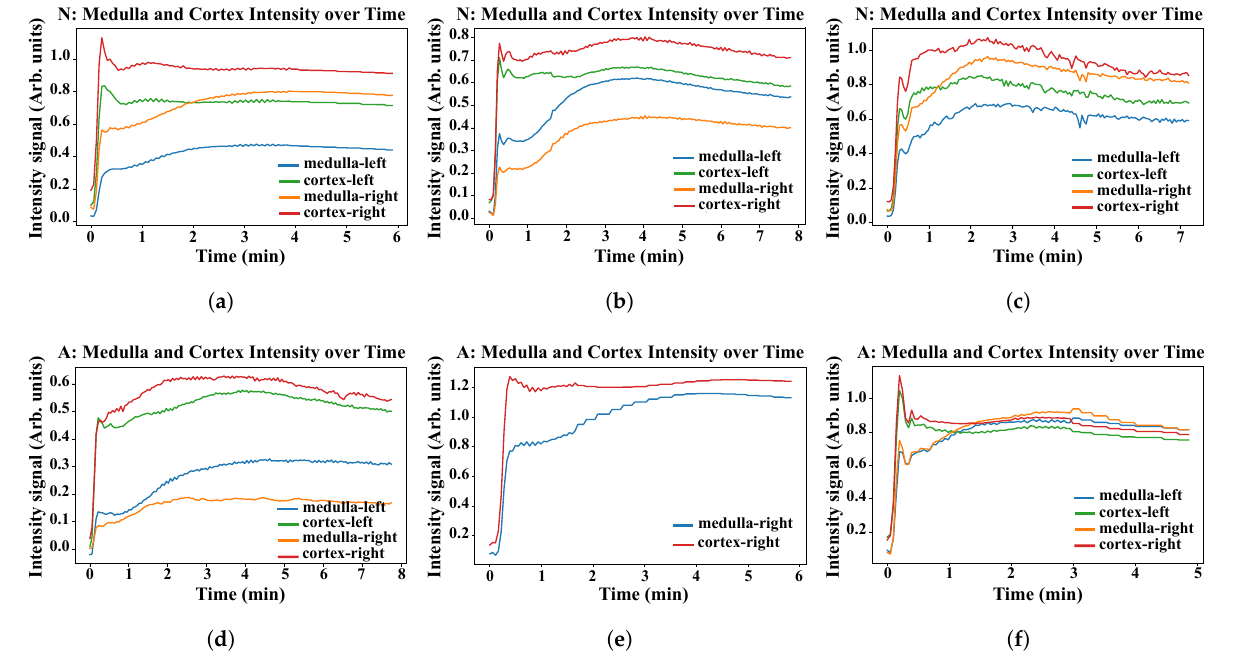
Figure 7. Graphs ( a – f ) represent clinically “normal” and “abnormal” cases (scans or 4D volumes), respectively. The relative contrast intensity enhancement of the (automatically segmented) medulla and cortex in both the left and right kidneys is shown over time (minutes).